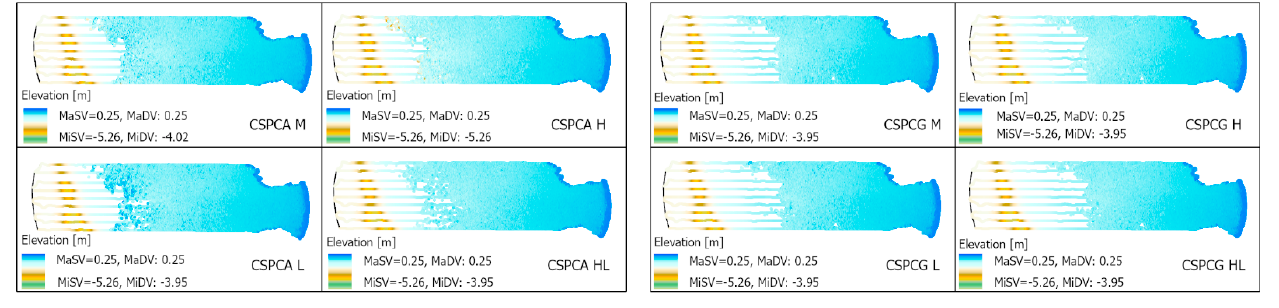
Figure 17. Integrated USV and UAV data (for better profile visualization, larger point symbols were used).